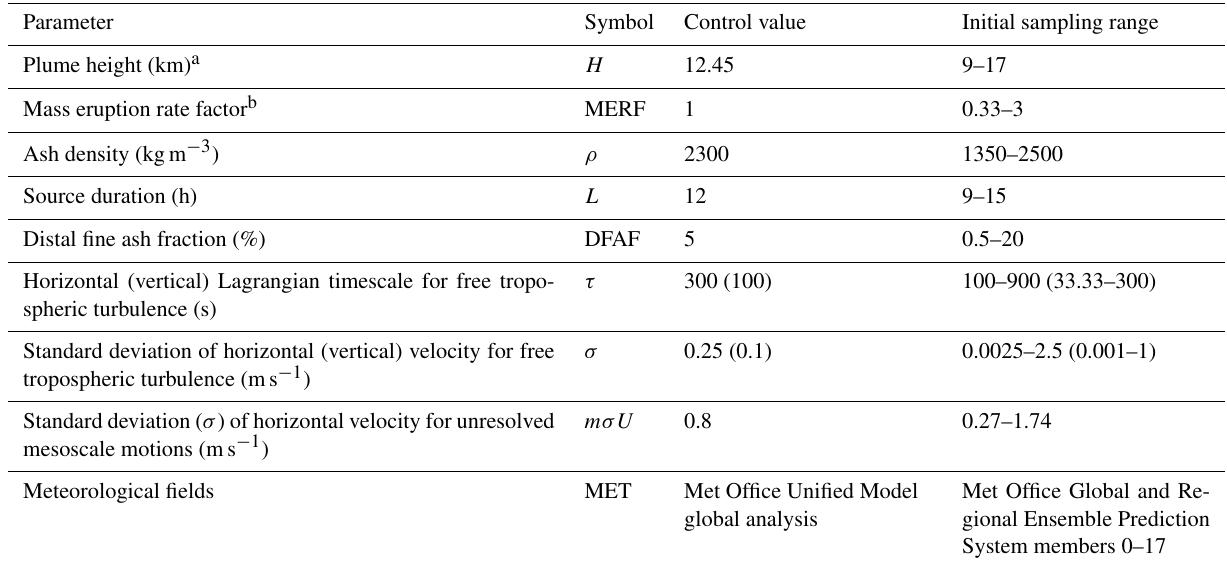
Table 1. Parameters sampled and their control and initial sampling ranges.